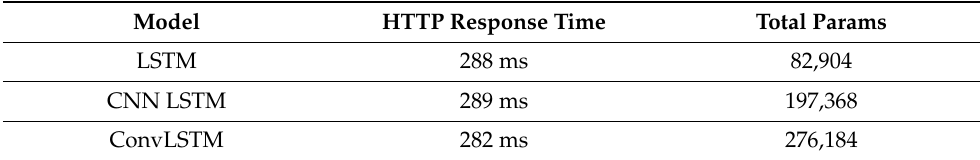
Figure 18. POST inference response .